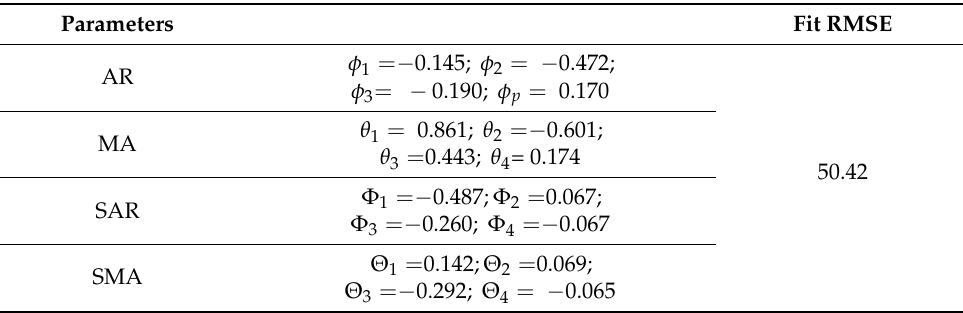
Table 2. ARIMA parameters and RMSE for fitted